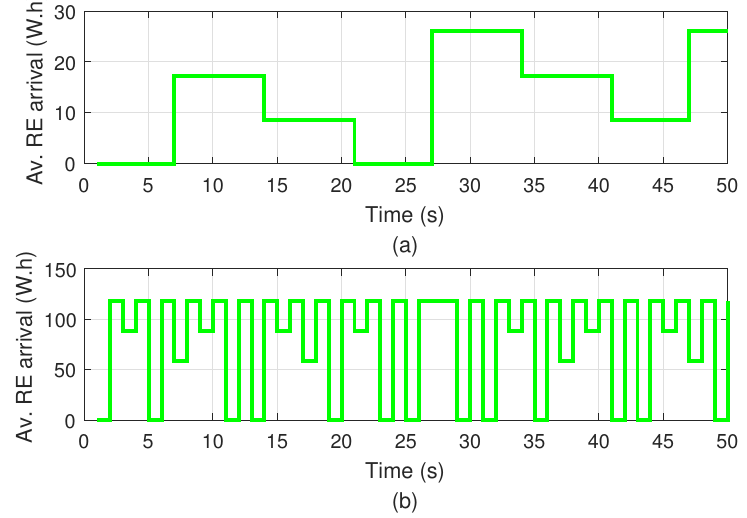
Figure 3. Average Renewable Energy (RE) arrival: ( a ) 9-BS network, and ( b ) 37-BS network.